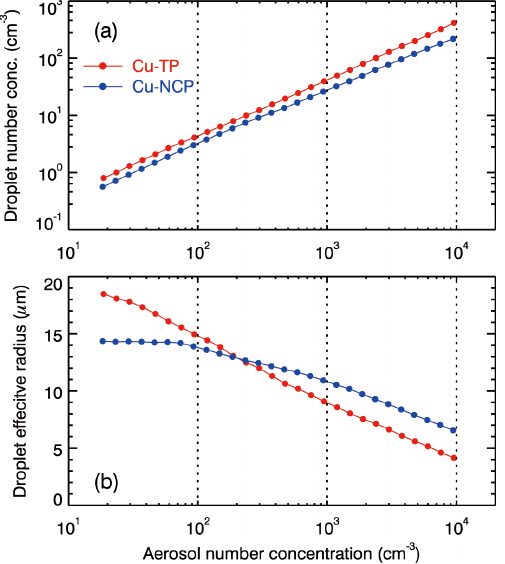
Figure 2. Modeled p mean of (a) cloud droplet number concen- tration and (b) effective radius as a function of the initial [ N a ] in Cu-TP and Cu-NCP.